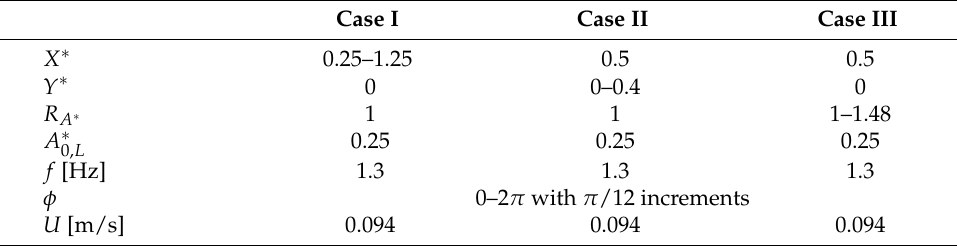
Table 1. Experimental parameters and input variables used in the present